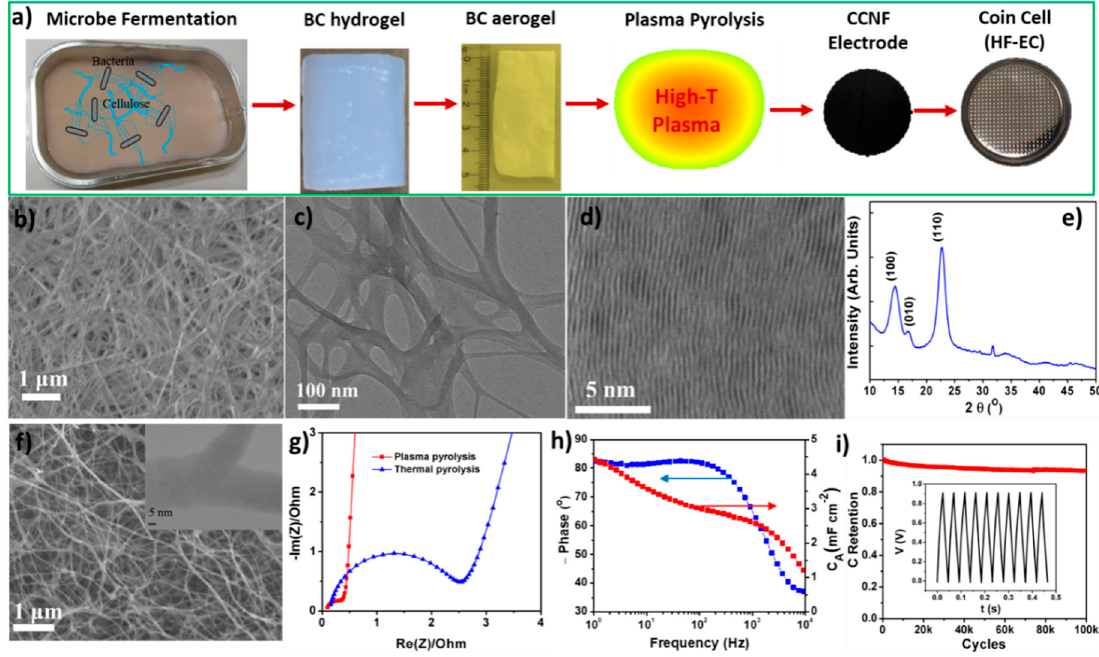
Figure 6. ( a ) Schematic showing the BC-derived CCNF fabrication processes and their electrochemical test. ( b ) SEM image of BC aerogel. ( c ) TEM image showing the cross-linked structure of BC nanofibers. ( d ) High-resolution TEM image and ( e ) XRD pattern showing the high crystalline of BC. ( f ) SEM image of CCNF showing the macroporous structure. The inset TEM image shows branched CNF. ( g ) Comparison of complex impedance spectra between CCNF produced by rapid plasma pyrolysis and conventional thermal pyrolysis. ( h ) Plots of phase angle and electrode capacitance vs. frequency for a 20 µ m thick CCNF electrode. ( i ) Galvanostatic charge-discharge stability result at a current density of 50 mA cm − 2 for a 10 µ m CCNF electrode, with the inset as a section of the C-D curve. Reproduced with permission from Ref. [13] Copyright 2017, Elsevier.